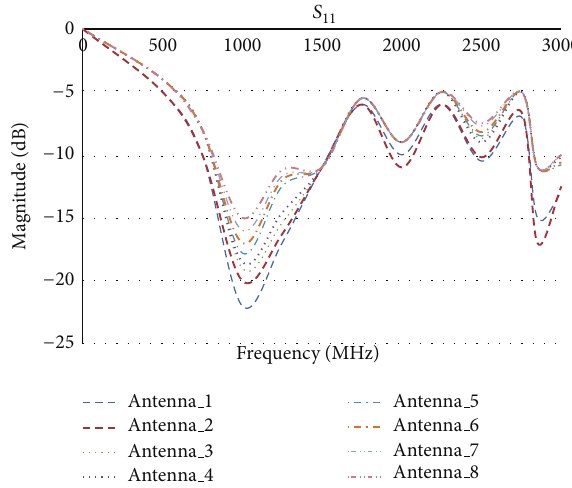
Figure 4: Measured return loss for (a) the clinical imaging system’s traditional encapsulated monopoles (antenna 1 and antenna 2, resp.), (b) the straight monopoles prior to bending (antenna 3 and antenna 4, resp.), (c) the bent monopoles (antenna 5 and antenna 6, resp.), and (d) the bent monopoles incorporating the rotary joint (antenna 7 and antenna 8,